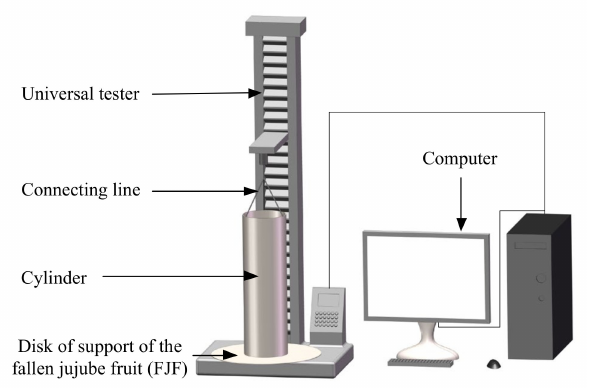
Figure 2. The angle of repose test device for the cylinder lifting method.